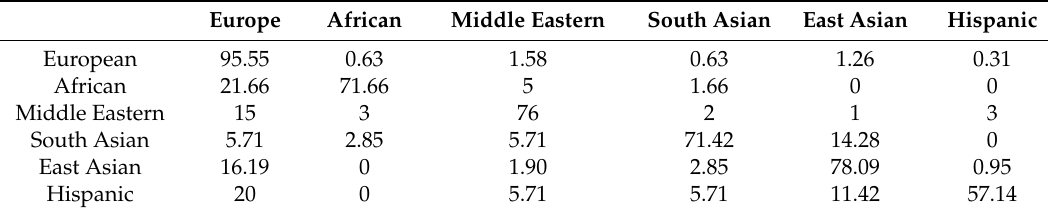
Table 8. Confusion Matrix of Race Attribute for L*a*b* Using PCLBP and